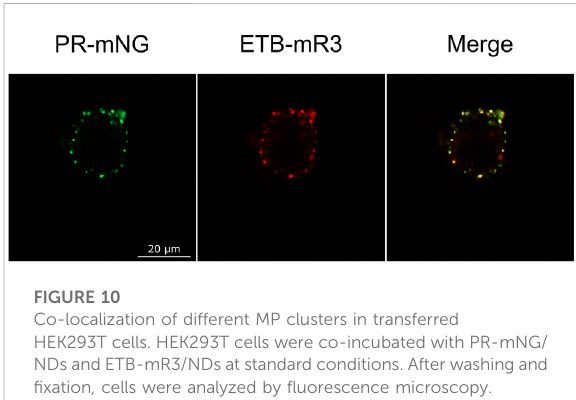
FIGURE 10 Co-localization of different MP clusters in transferred HEK293T cells. HEK293T cells were co-incubated with PR-mNG/ NDs and ETB-mR3/NDs at standard conditions. After washing and fi xation, cells were analyzed by fl uorescence microscopy. Images of a representative cell are